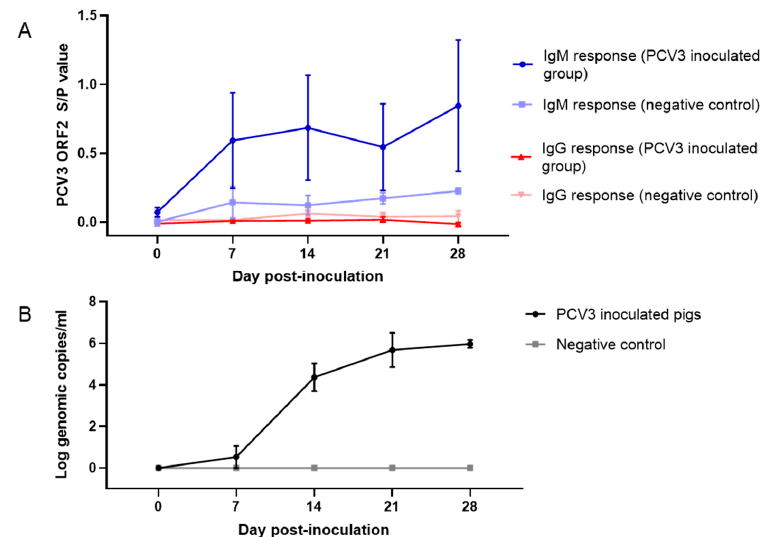
Figure 6. Infection dynamics in 6-week-old CD / CD pigs ( n = 14) following experimental inoculation with either 2 mL of infection medium ( n = 6; negative control group) or 2 mL of PCV3 isolate ISU27734 ( n = 8; PCV3 inoculated group). IgG / IgM antibody responses (mean S / p values) detected by PCV3 rORF2 iELISA over the course of the infection ( A ). Viral loads detected by qPCR (mean log genomic copies per mL) over the course of the infection ( B ).